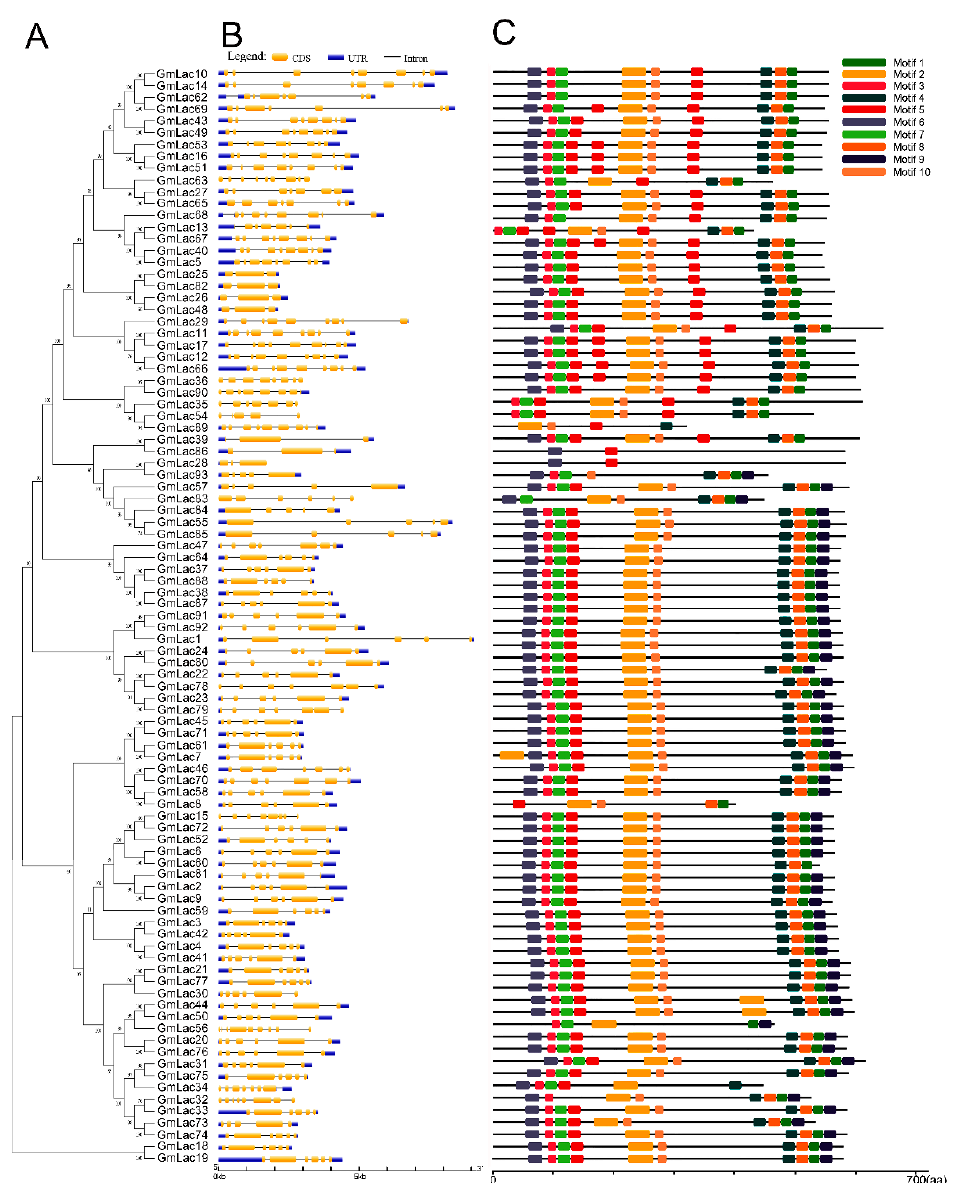
Figure 4. Phylogenetic relationships, gene structure, and motif compositions of the soybean laccase gene family. ( A ) A neighbor-joining tree of 93 GmLac protein sequences constructed using MEGA v7.0. ( B ) The structure of the 93 GmLac genes. Yellow squares correspond to exons and linking black lines indicate introns, while the blue squares refer to the 5 (cid:48) untranslated region (UTR) and 3 (cid:48) UTR sequences. ( C ) Schematic motif composition of 93 GmLac proteins. The colored boxes represent the di ff erent motifs, indicated in the top right-hand corner. The scales at the bottom of the image indicate the estimated exon / intron length in kb and motif length in numbers of amino acids